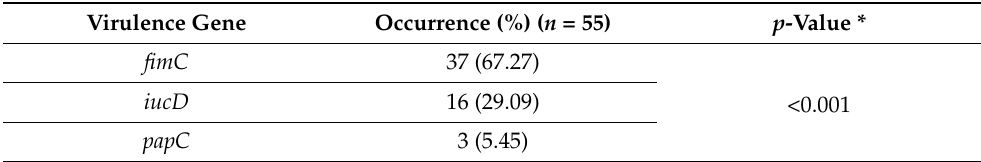
Table 1. Prevalence of avian pathogenic E. coli (APEC)-associated virulence genes in E. coli isolated from fecal matter of migratory birds.